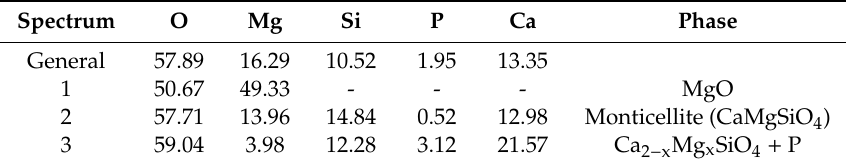
Table 3. EDS analysis (atom %) for directionally solidified rods at 50 mm /